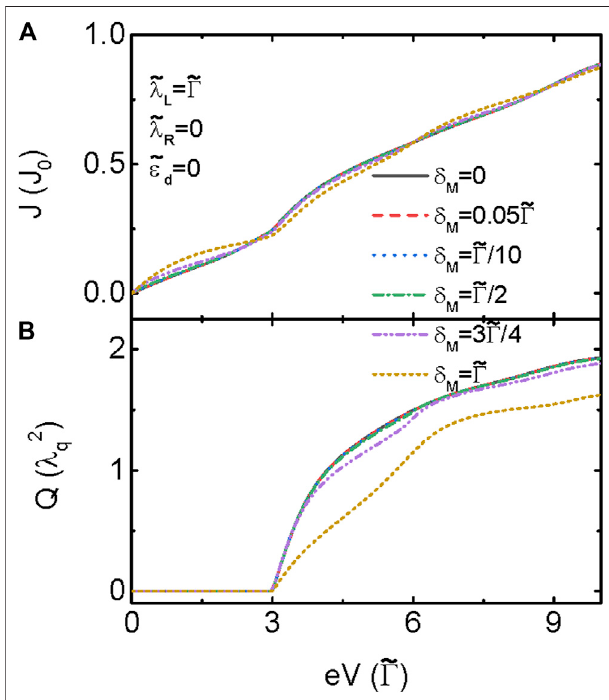
FIGURE 3 | (A) Electrical current and (B) heat generation as functions of thebiasvoltageatdifferent δ M .Otherparametersarethesameasin Figure2 .